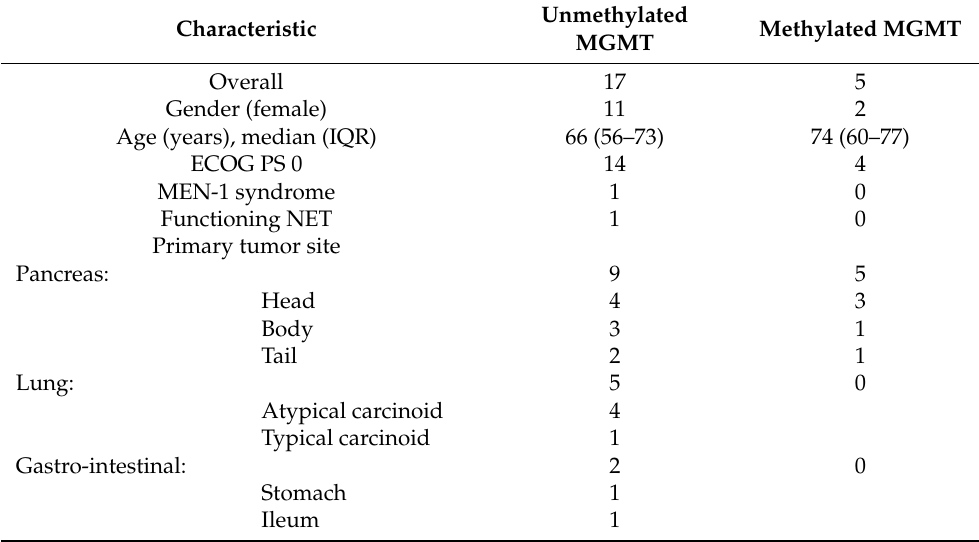
Table 2. Patients’ baseline characteristics by MGMT -promoter methylation